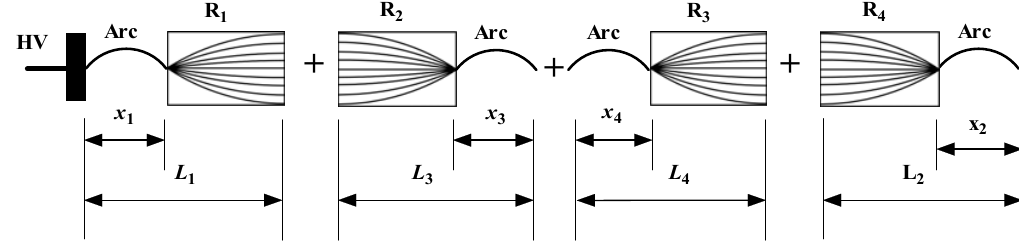
Figure 4. Equivalent single-arc residual resistance calculation model for three